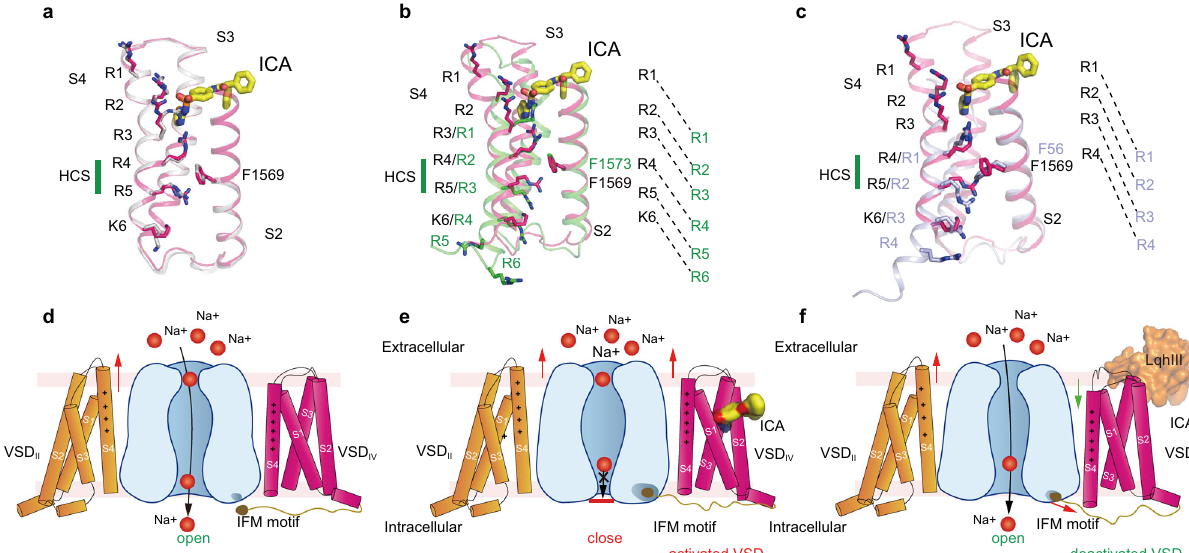
Fig. 5 Allosteric inhibition mechanism for modulation of Na V 1.3 by ICA. a – c Comparison of ICA-bound VSD IV of Na V 1.3 with activated apo-VSD IV of Na V 1.3 ( a ), deactivated LqhIII-bound VSD IV of Na V 1.5 ( b ), and the resting state VSD of Na V Ab ( c ). ICA and side chains of gating charges shown in sticks. Green bar indicates the position of hydrophobic constriction site (HCS). Dashed lines indicate gate charge shifts at different states. d Activation of VSD IV controls fast inactivation of Na V s. VSD II activation (red arrow) leads to gate opening, and VSD IV is not activated so the IFM motif is released from the receptor site. Domain I and III are hided for clarity. e ICA stabilizes the activated conformation of VSD IV of Na V 1.3 and induces inactivation of the channel. VSD IV is activated and stabilized by ICA, IFM motif binds tightly to the receptor site and closes the gate. f LqhIII stabilizes the deactivated conformation of VSD IV of Na V 1.5 and induces the opening of the channel. LqhIII binding pushes downward shift (green arrow) of S4 IV and destabilizes the binding of IFM motif to the receptor site (red arrow), the release of IFM motif leads to channel